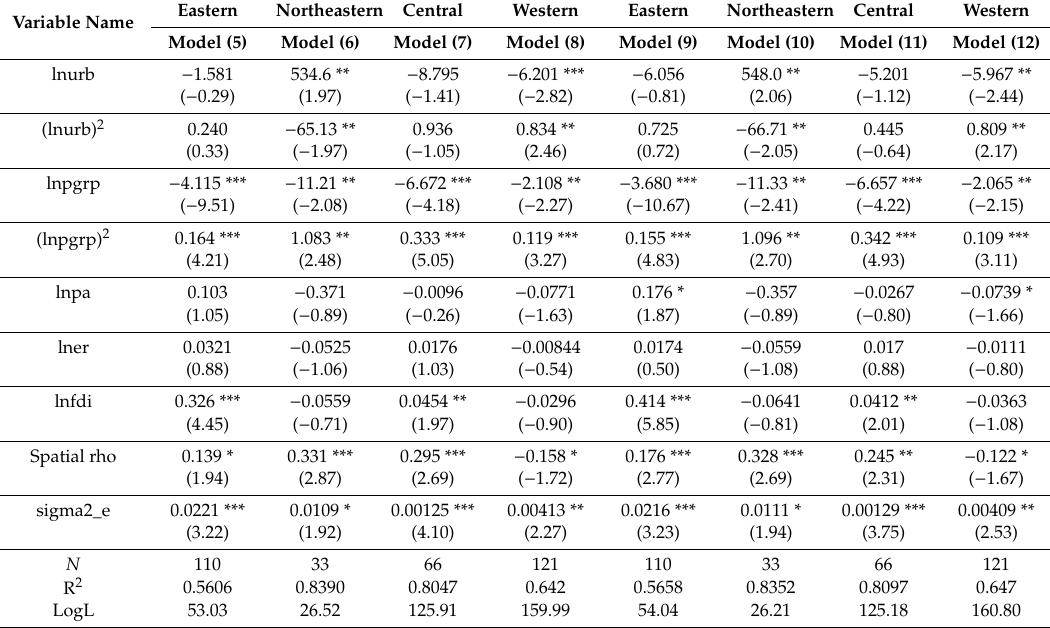
Table 4. Estimated results of the regional Durbin model.